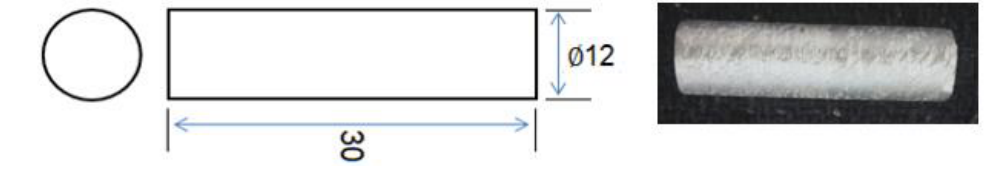
Figure 4. Compression test sample.